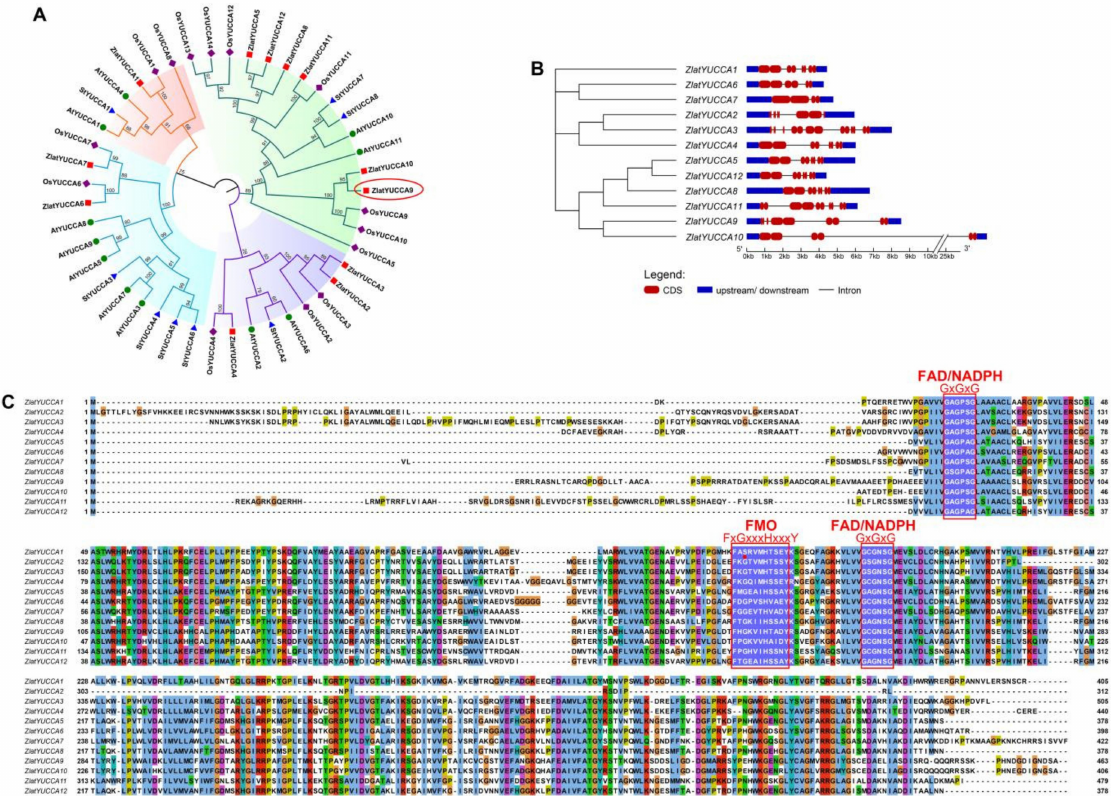
Figure 7. YUCCA gene family analysis. ( A ) Phylogenetic analysis of the YUCCA protein in Z. latifolia , Arabidopsis , rice and potato. ( B ) Structural analysis of the YUCCA family. ( C ) The complete protein sequences of YUCCA family proteins were aligned by ClustalW. The FMO (FxGxxxHxxxY), FAD (GxGxG) and NADPH-binding (GxGxG) domains are marked with a red